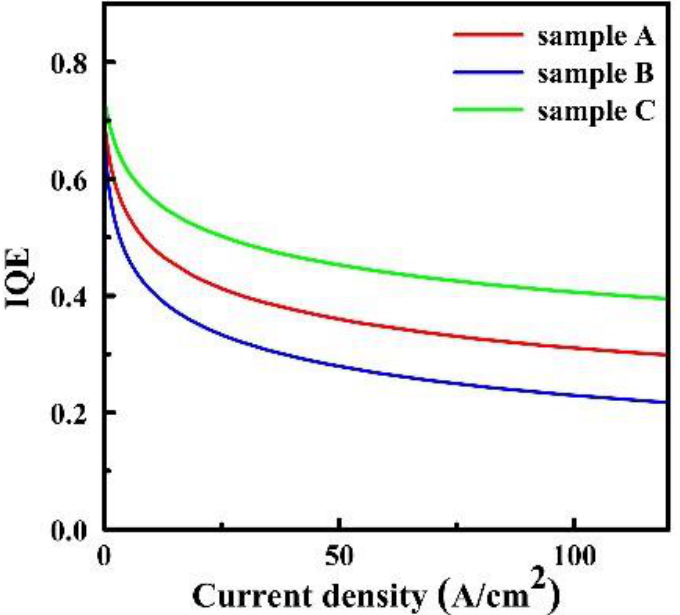
Figure 4. IQE with respect to current density of sample A, sample B and sample C. Figure 5 exhibits the emission spectrum of three samples. As presented in Figure 5, three samples all emit in the yellow spectral region under 1 A/cm 2 current density. The peak wavelengths of the three samples shift to the shorter region with increasing current density. When the current density increases from 1 A/cm 2 to 60 A/cm 2 , the blueshift values of peak emission wavelength for sample A, sample B and sample C are 14.4 nm, 16.5 nm and 13.0 nm, respectively. The polarization electric field in MQWs can be reflected by the blueshift of peak emission wavelength [34]. Owing to the alleviated polarization effect and partly self-screened QCSE, sample C possesses the minimum value of blueshift among the three samples, which further confirms our aforementioned